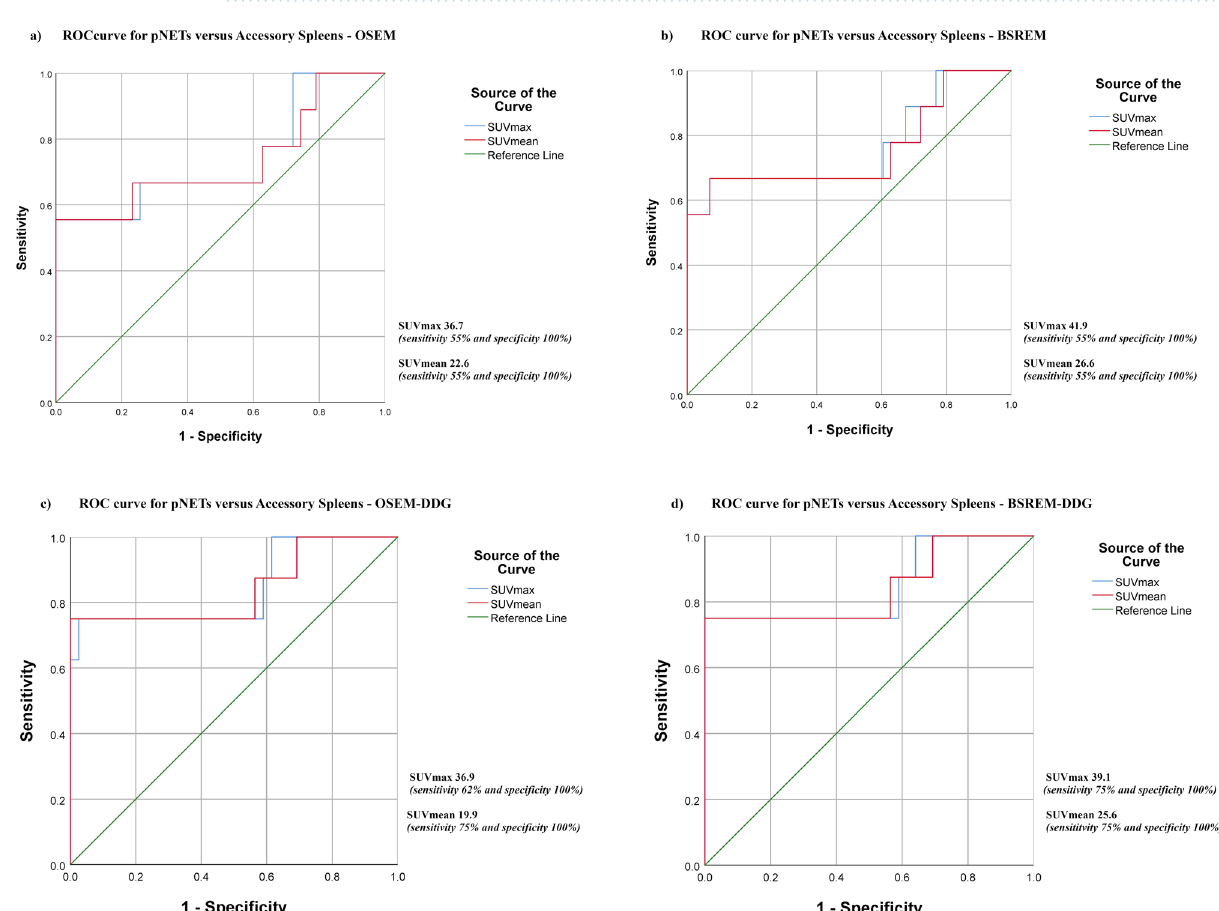
Figure 6. ROC curve of SUVmax and SUVmean for discriminating pNET and accessory spleens with OSEM (AUC = 0.742 and p = 0.024 of SUVmax; AUC = 0.734 and p = 0.029 of SUVmean ( a )), BSREM (AUC = 0.765 and p = 0.013 of SUVmax; AUC = 0.755 and p = 0.017 of SUVmean ( b )), OSEM-DDG (AUC = 0.846 and p = 0.002 of SUVmax; AUC = 0.843 and p = 0.002 of SUVmean ( c )) and BSREM-DDG (AUC = 0.846 and p = 0.002 of SUVmax; AUC = 0.843 and p = 0.002 of SUVmean ( d )) reconstructions in the sub-cohort of patients retrospectively acquired (42 accessory spleens, 6 IPAS and 8